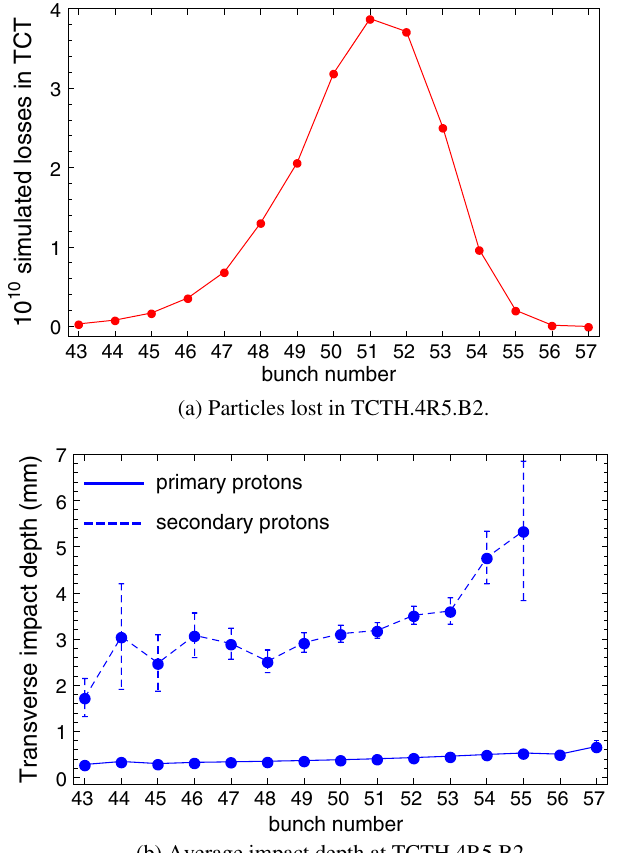
FIG. 16. Losses and impact parameter given as a function of bunch number for Case 3. A bunch population of 2 . 2 × 10 11 p = b has been considered to estimate the losses on the TCT.